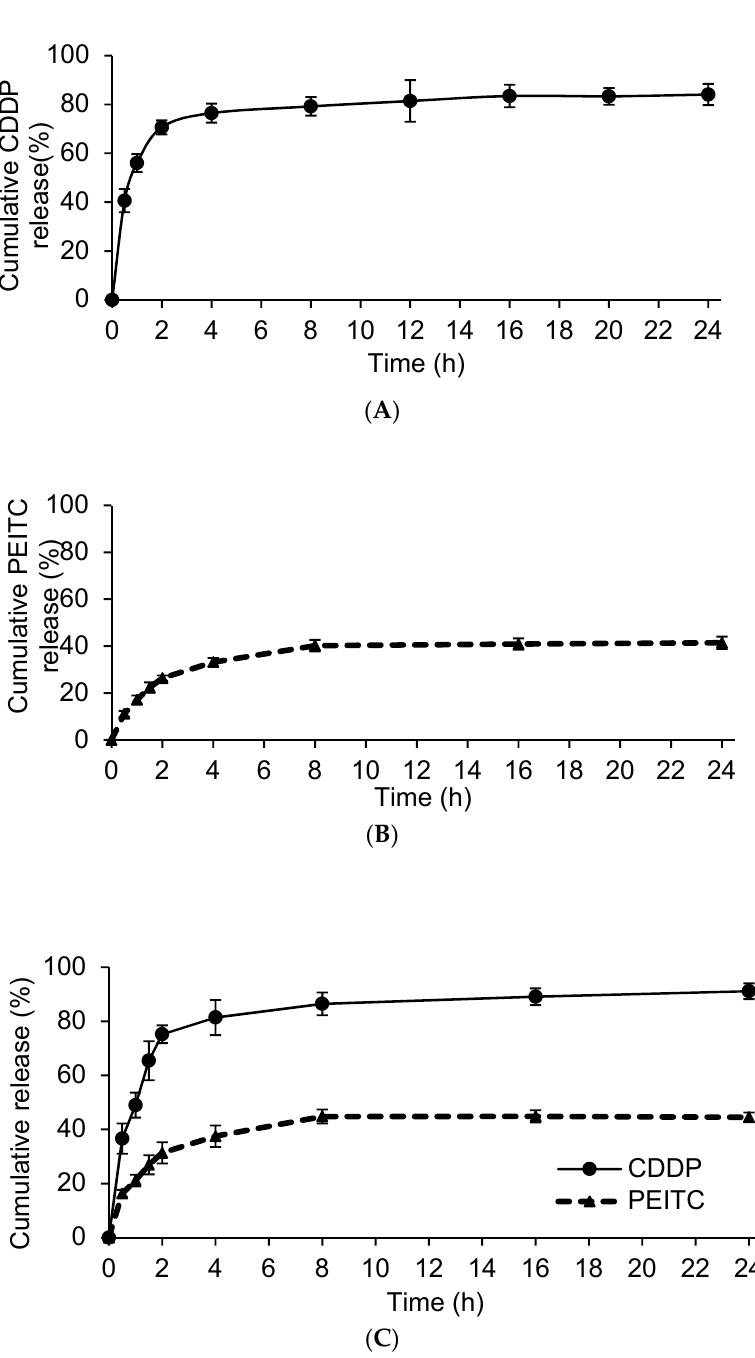
Figure 2. ( A ) In vitro cisplatin (CDDP) release profile from liposomes containing CDDP (Lipo-CDDP); ( B ) in vitro phenethyl isothiocyanate (PEITC) release profile from liposomes containing PEITC (Lipo-PEITC); and ( C ) in vitro CDDP and PEITC release profiles from liposomes containing both compounds